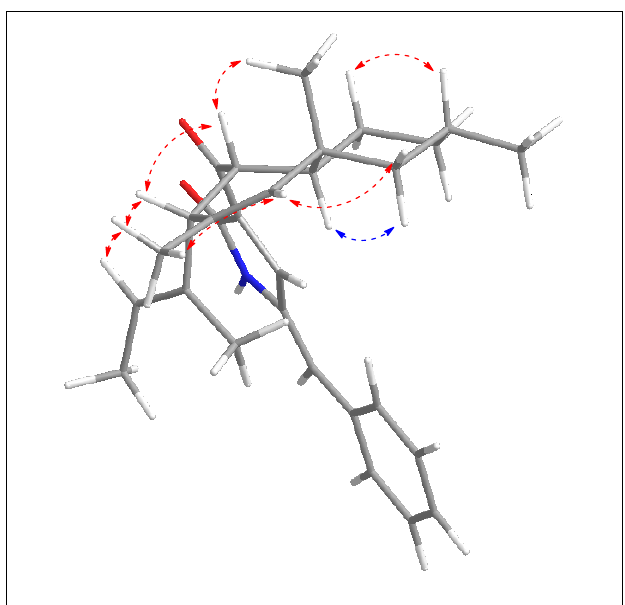
FIGURE 4 | Key NOESY correlations of 1